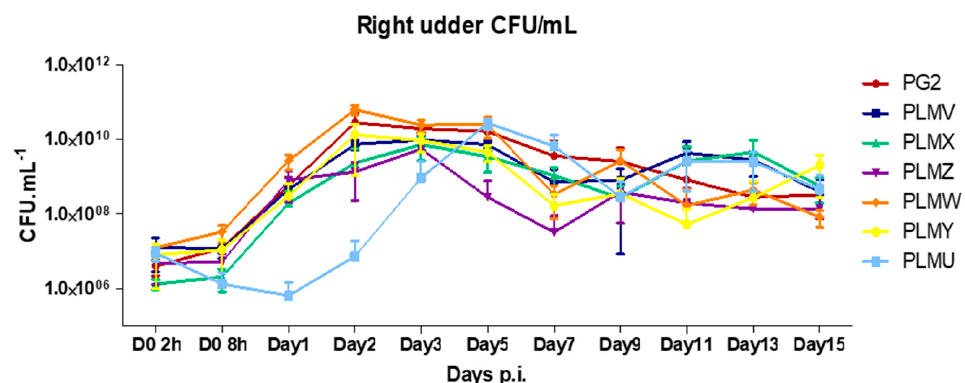
Figure 3. M. agalactiae load in milk samples obtained from the inoculated right udder halves of ewes experimentally infected with 10 9 cfu of six different Vpma PLMs (PLMV, PLMX, PLMZ, PLMW, PLMY and PLMU) and type strain PG2. Mean log 10 cfu values of mycoplasmas per milliliter of milk from three sheep in each group are plotted and bars represent standard error of the mean.